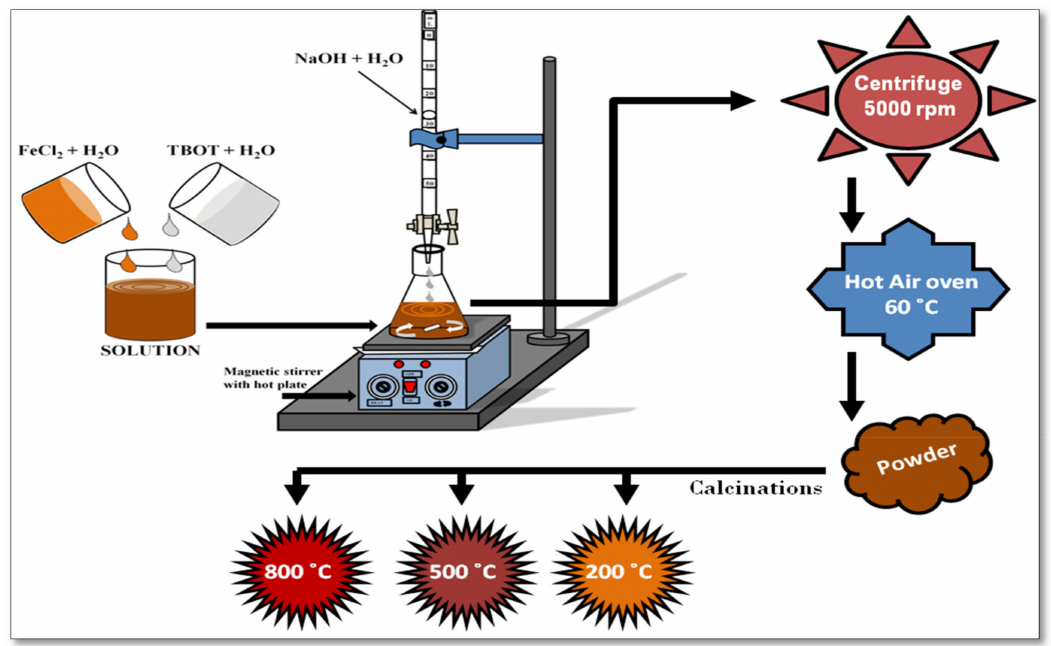
Figure 1. Procedure illustration for the synthesis of titanium ferrite NPs using the co-precipita- tion